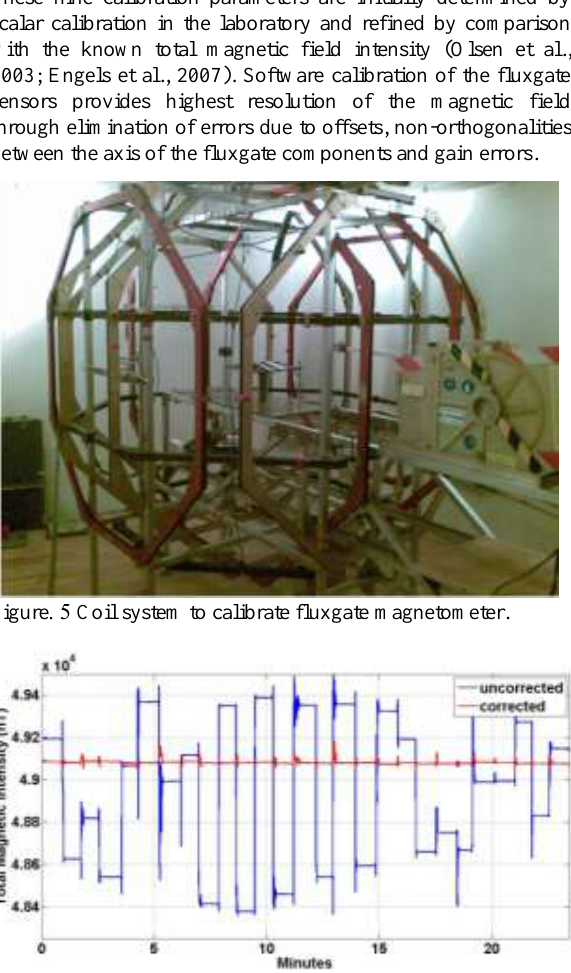
Figure 6 TMI before (blue) and after (red) correction for gain, offset and non-orthogonalities between axes. After correction the TMI is nearly independent from the orientation of the sensor in the magnetic field.